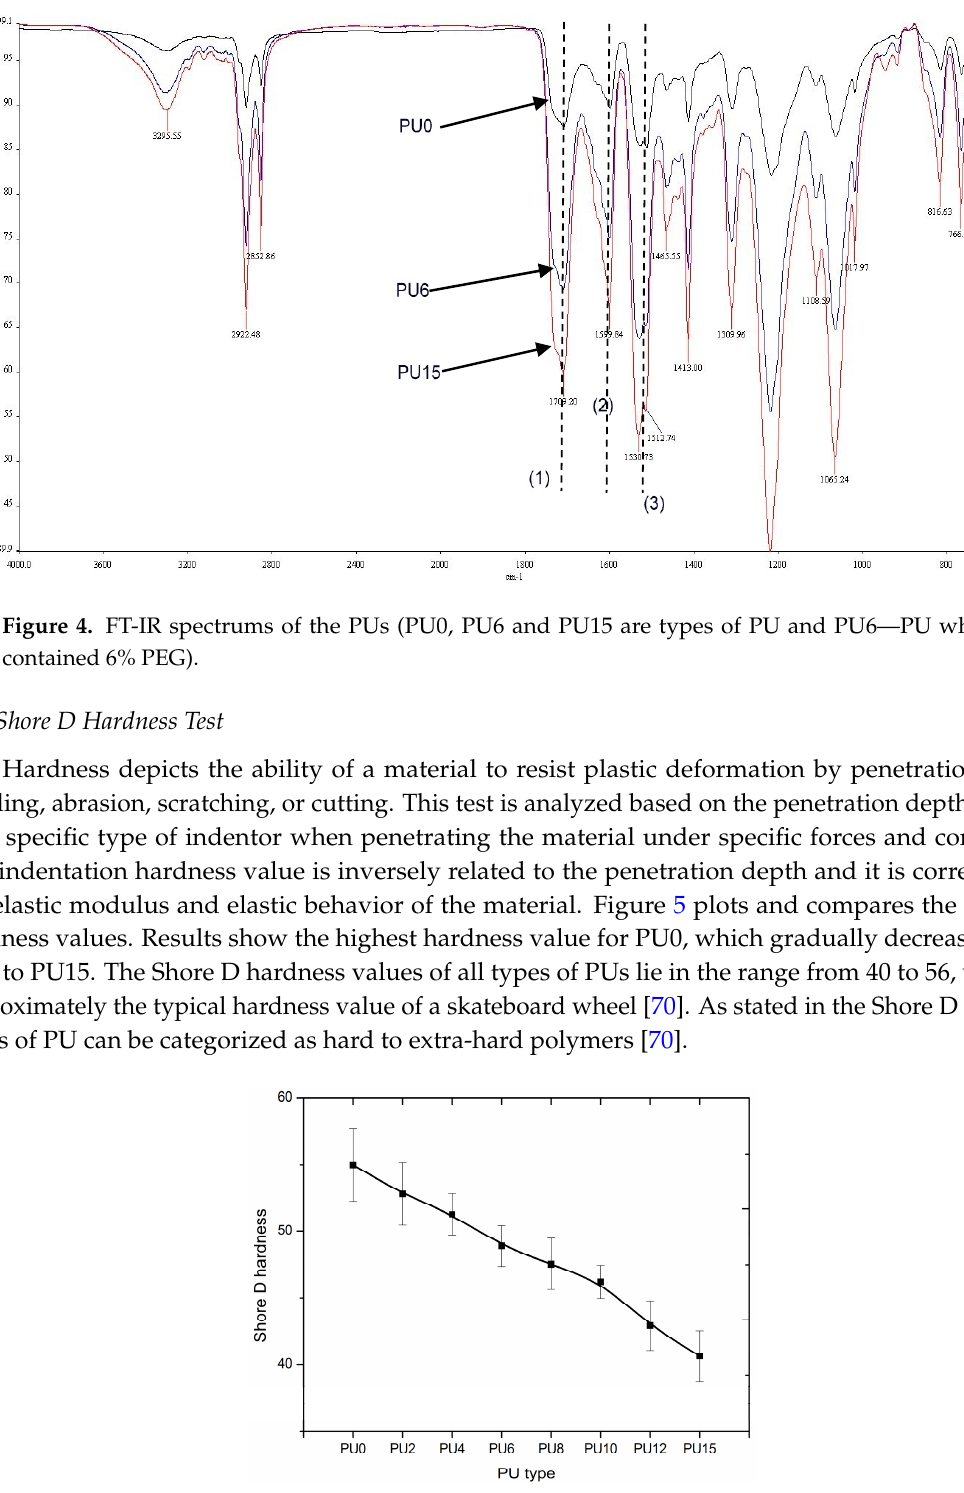
Figure 5. Shore D-Hardness value (PU0–PU15 are types of PU and PU6—PU which contained 6% PEG).